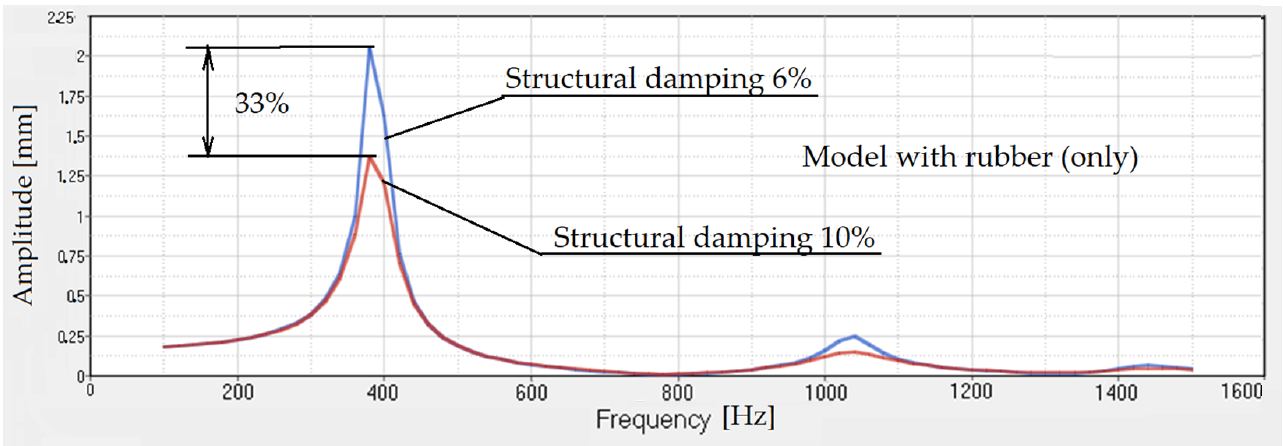
Figure 10. Transmissibility for rubber with 1320 steel balls. The structural damping is 6% and 10%.